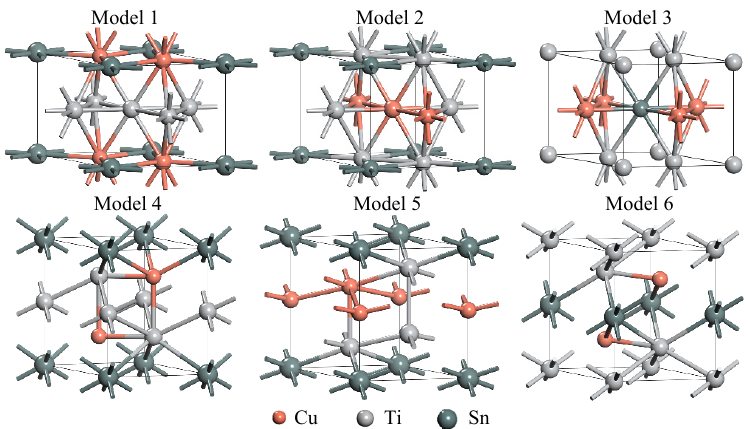
Figure 3. Models 1–6 showing the most favorable atomic structures. Red, gray, and dark green spheres represent Cu, Ti, and Sn atoms, respectively.